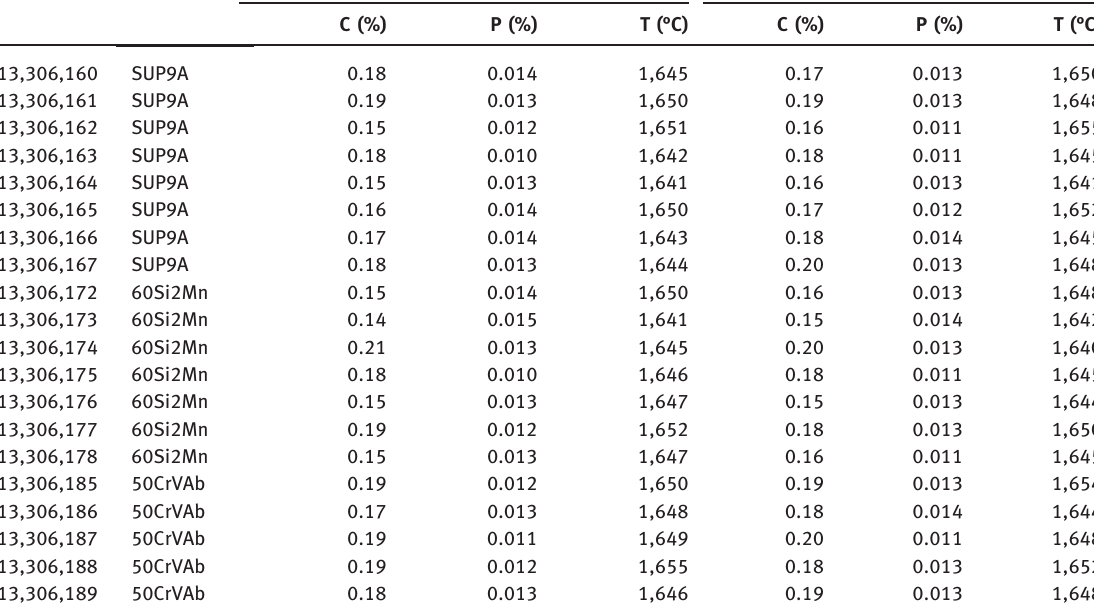
Table 1: Validation of the reblow